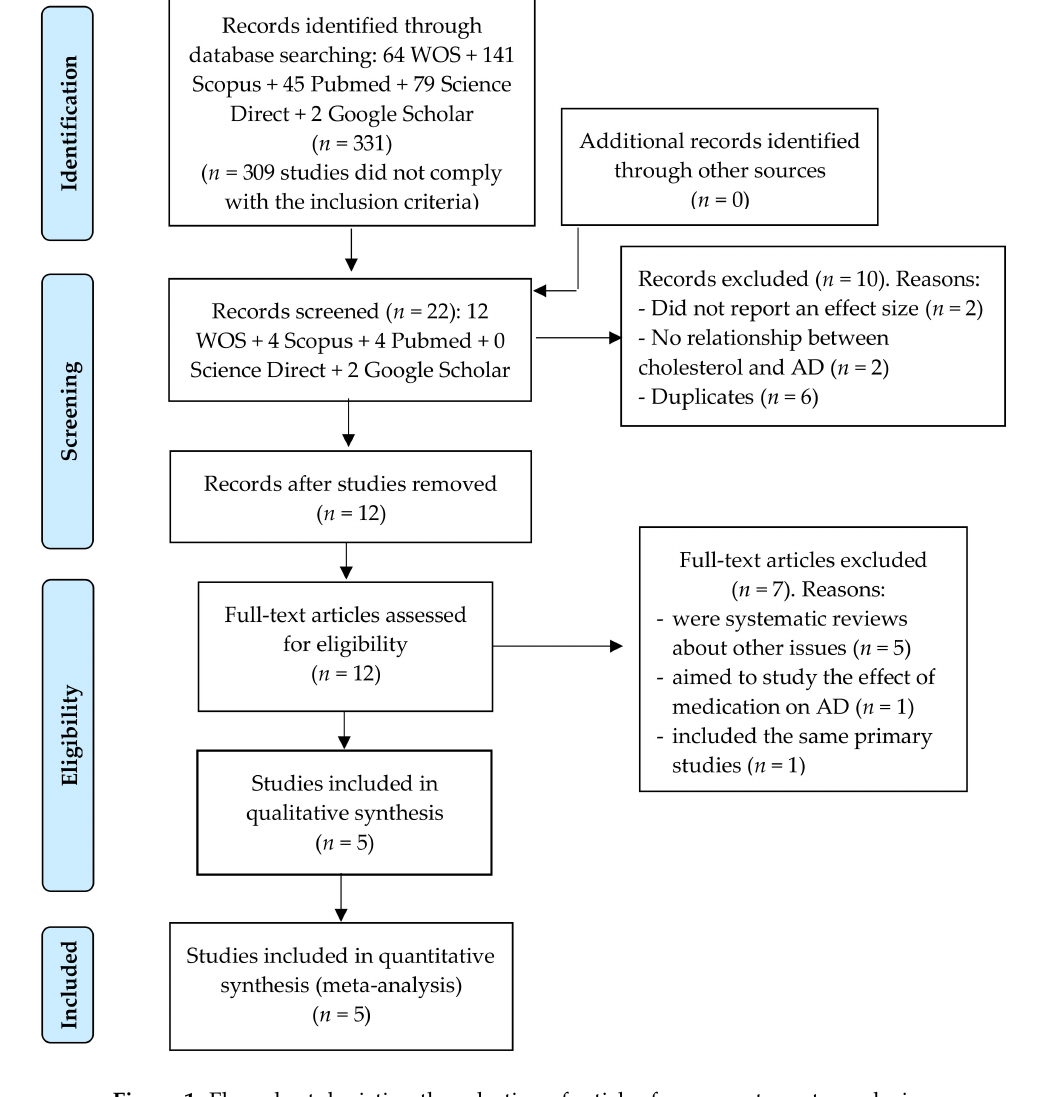
Figure 1. Flow chart depicting the selection of articles for our